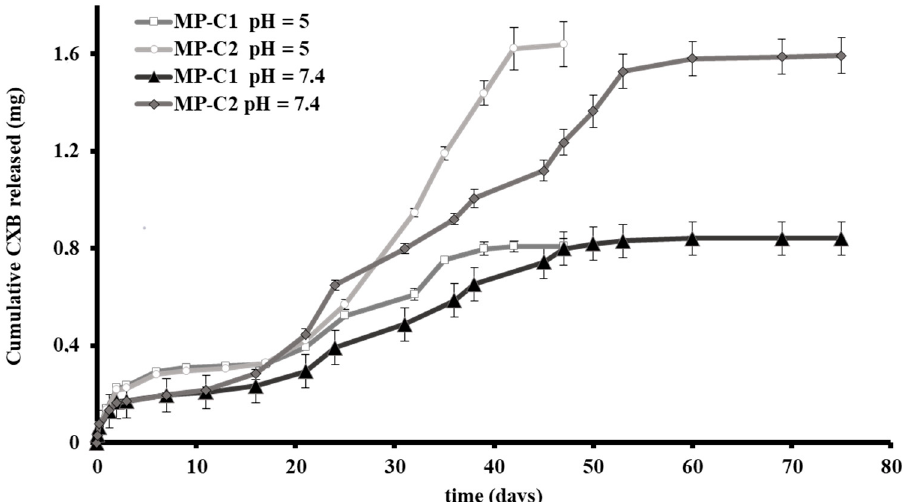
Figure 2. Cumulative amounts ( ± SD) of CXB released from CXB-loaded PLGA MPs (MP-C1 and MP-C2) at pH 5 and pH 7.4.